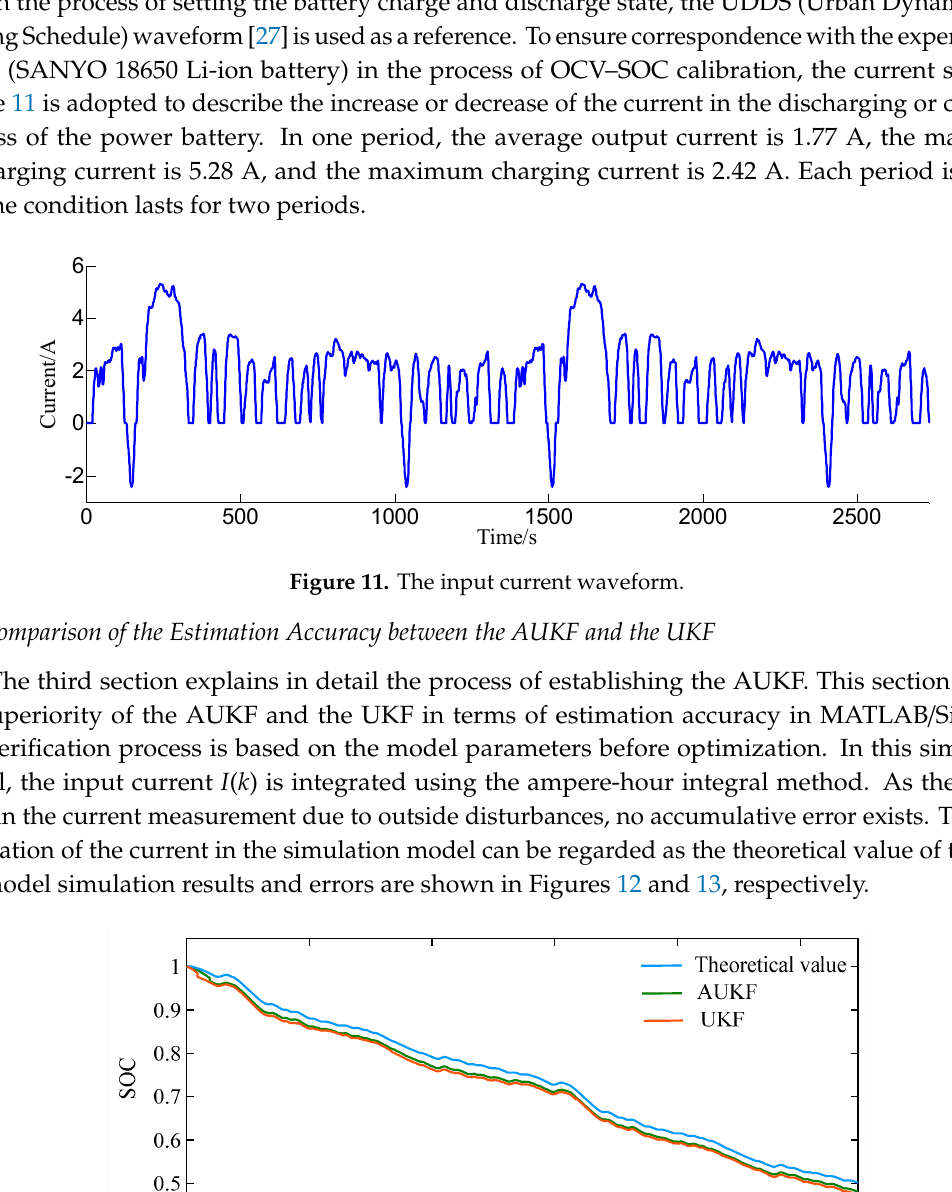
Figure 13. The model simulation errors. From the simulation results, the AUKF and the UKF can estimate the SOC online well under different charge and discharge rates. The UKF maximum estimation error is 2.98%, and the maximum estimated error of the AUKF is 2.28%; compared with the UKF, its estimation accuracy is significantly improved. 5.2. Comparison of the AUKF Estimation Accuracy Before and After Optimization of the Model Parameters